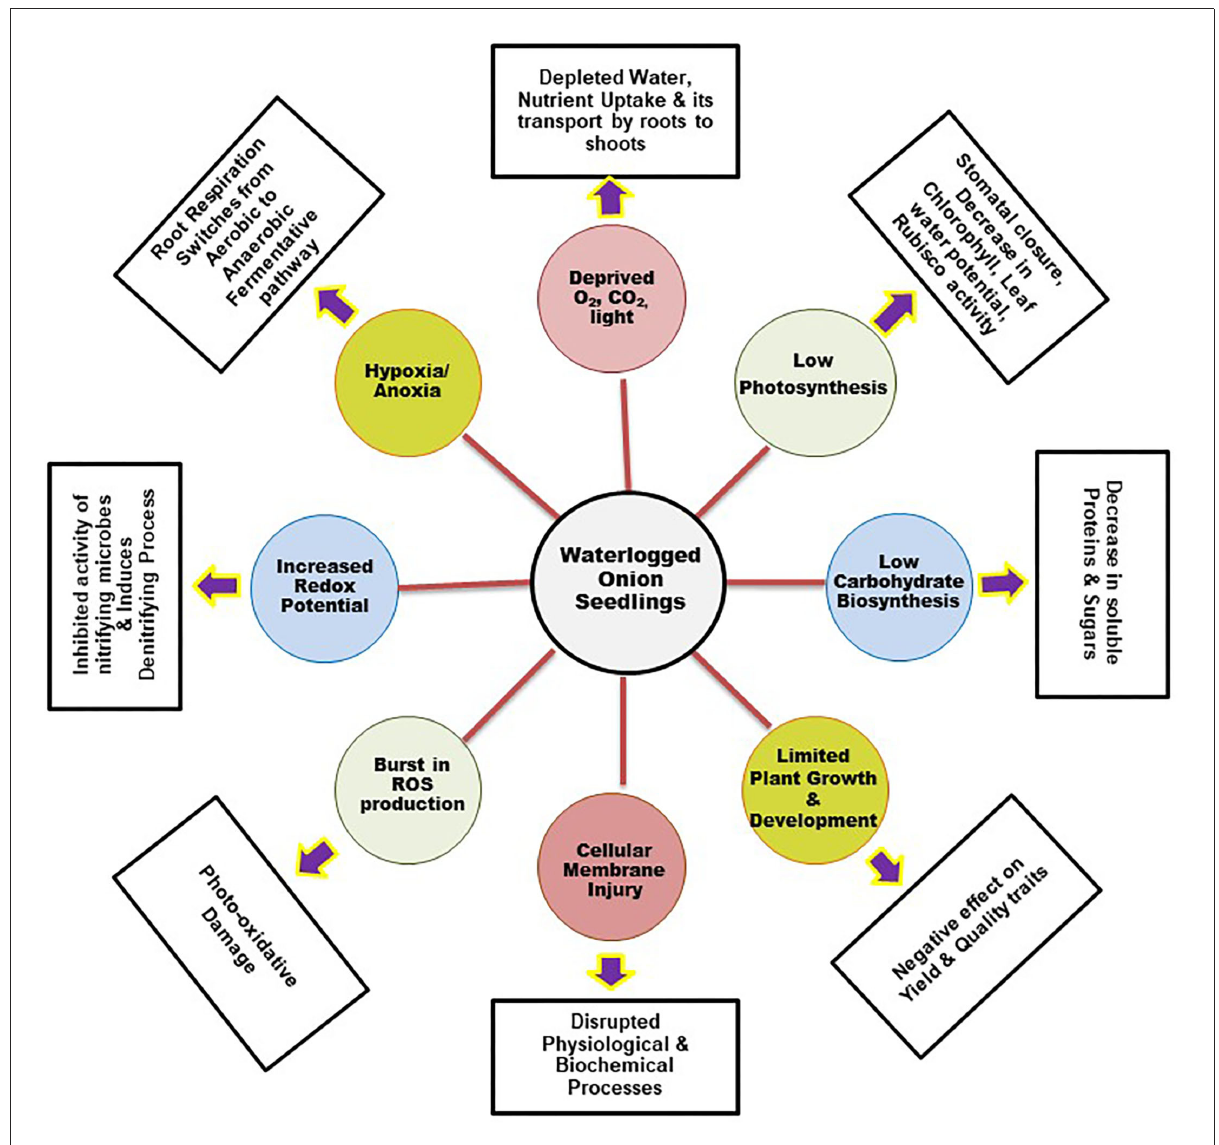
FIGURE5 Physiological changes in host due to waterlogging